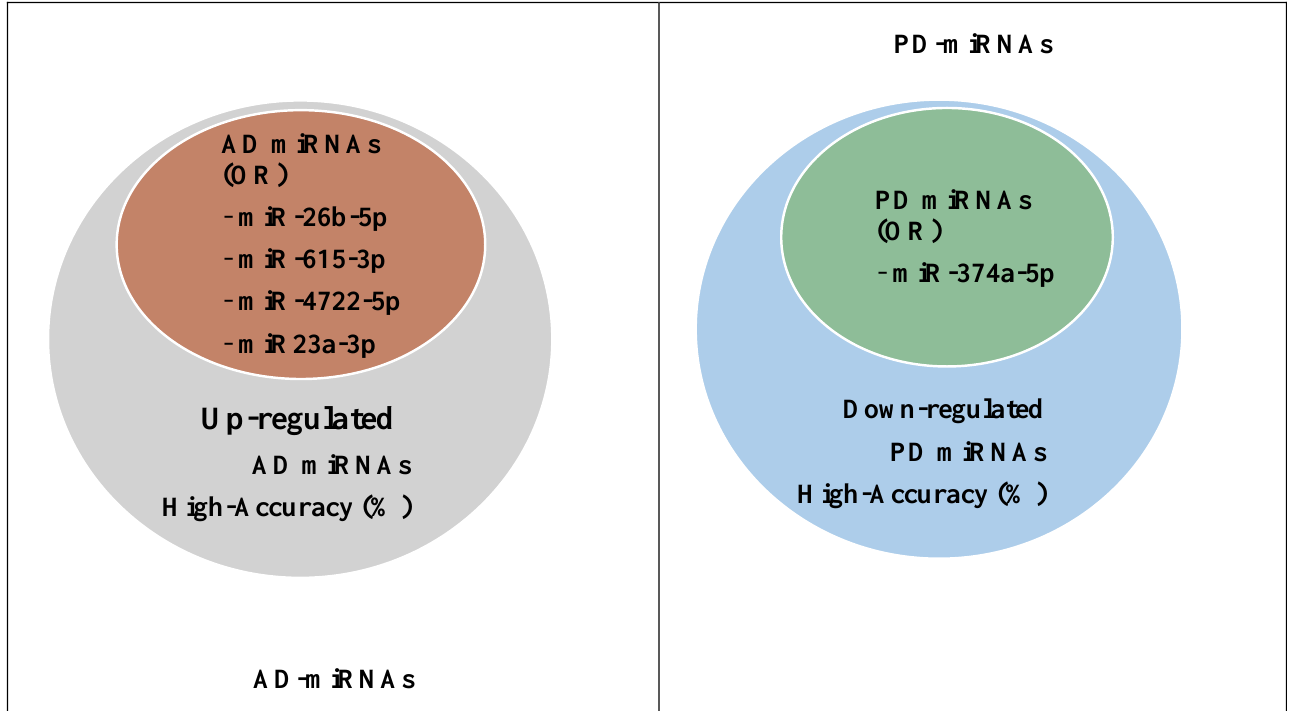
Figure 4. Illustrative scheme showing the inclusion of miRNAs from Table 7 in the respective groups of Figure 3. Alzheimer’s disease (AD); Parkinson’s disease (PD).